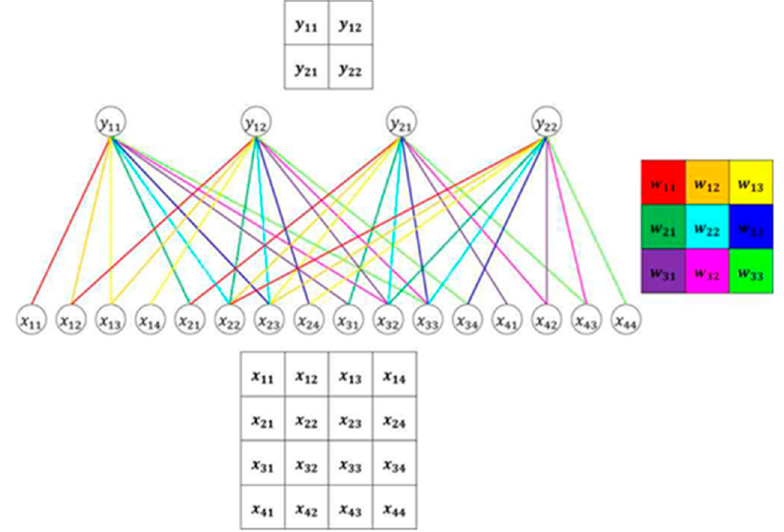
Figure 10. Example of convolution.